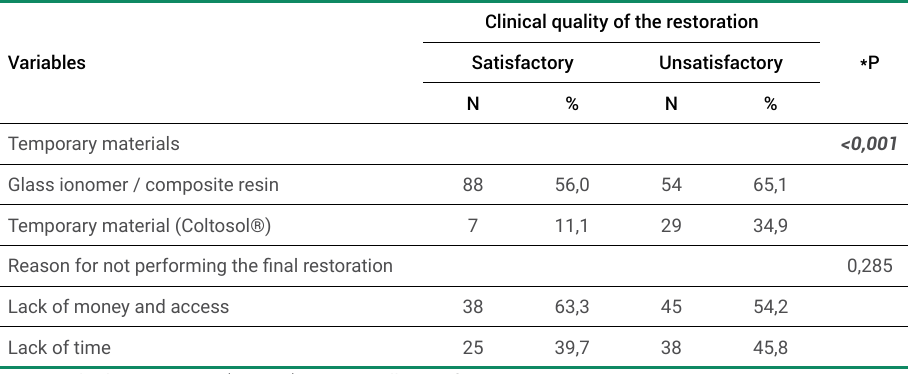
Table 4. Bivariate analysis between the temporary material, the reason for not performing the definitive restoration and the clinical quality of the provisional restoration of patients who did not adhere to the final restoration after endodontic treatment, Brazil, 2020 (n =